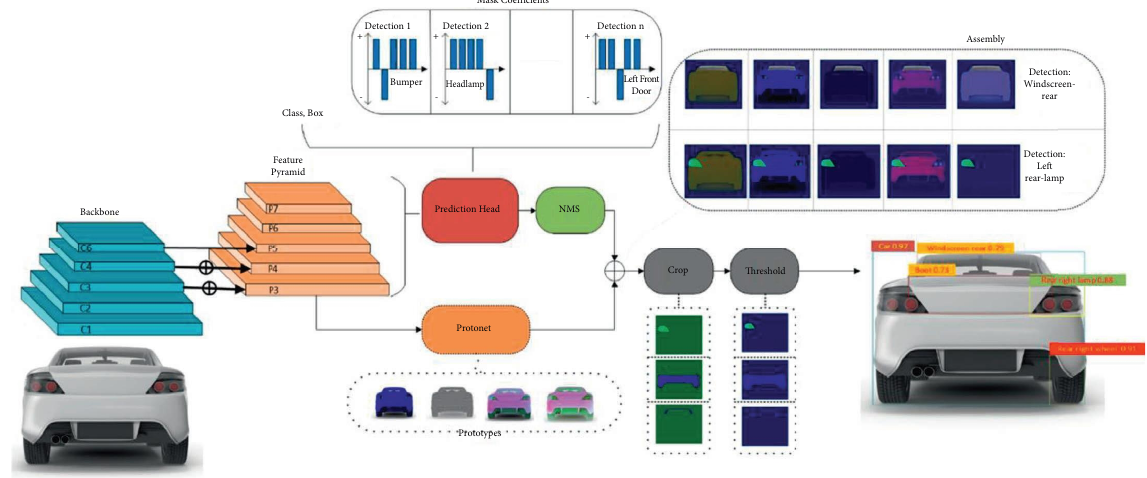
Figure 3: YOLACT architecture explained for the car parts segmentation use